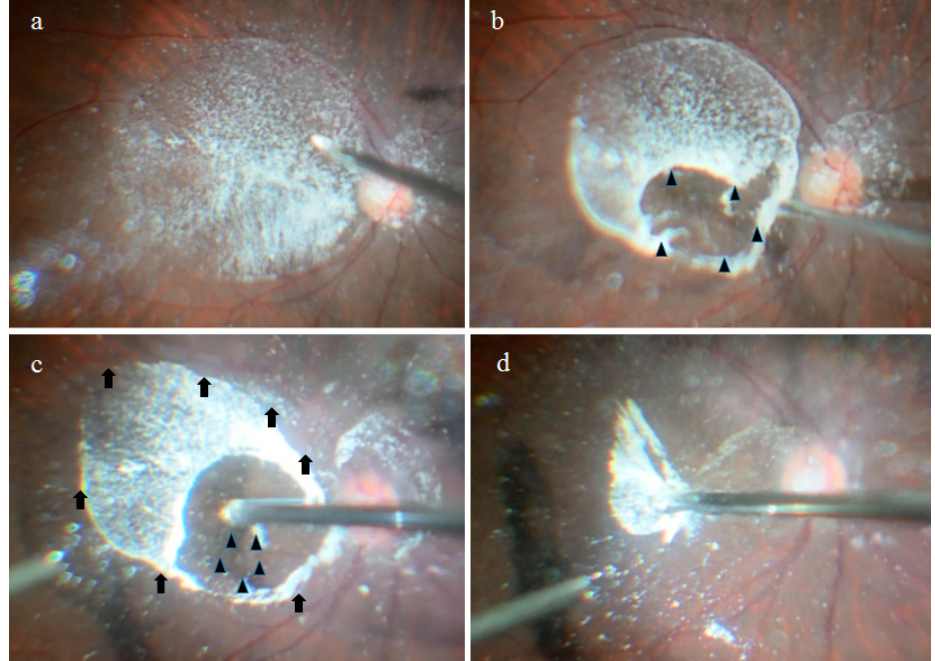
Figure 1. Surgical procedure used to obtain the bursa premacularis (BPM) specimens. Triamcinolone acetonide (TA) par- ticles were firmly adhered to only the surfaces of the BPM and the Martegiani area. The BPM was observed to be an oval or round thin tissue with a size of 5 to 6 disc diameters on the macula ( a ). Two penetrating holes were easily created in the anterior and posterior walls of the BPM by surgically scraping the surface with a diamond scraper ( b , c ); black arrowheads). Firm adhesion with a circular ligamentous structure was observed in the periphery of the BPM ( c ; thin black arrows), and this adhesion extended to the Martegiani area that also firmly adhered to the retina around the optic disc. The combined specimen of the BPM and Martegiani area was then separated from the retina via aspiration of the edge of the hole in the anterior wall of the BPM with a vitreous cutter. The tissue specimen was then released into the vitreous and selectively collected with a vitreous cutter ( d ).